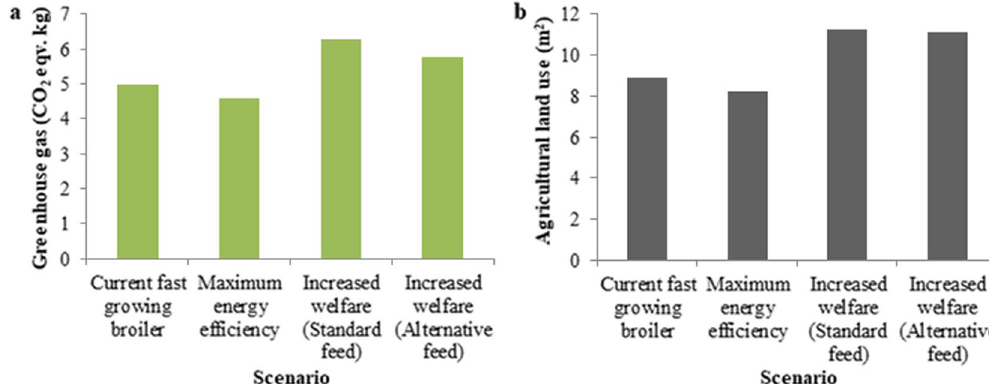
Figure 3. The environmental impact implications associated with feed provision for one broiler of each scenario grown to 2.2 kg. ( a ) shows greenhouse gas emissions (CO 2 eqv.) and ( b ) shows the agricultural land use (m 2 ). The following scenarios are presented: current fast-growing birds, maximum energy efficiency birds and slow-growing increased welfare birds placed on a standard feed, as well as slow-growing increased welfare birds placed on an alternative feed formulated specifically for the slow-growing line.